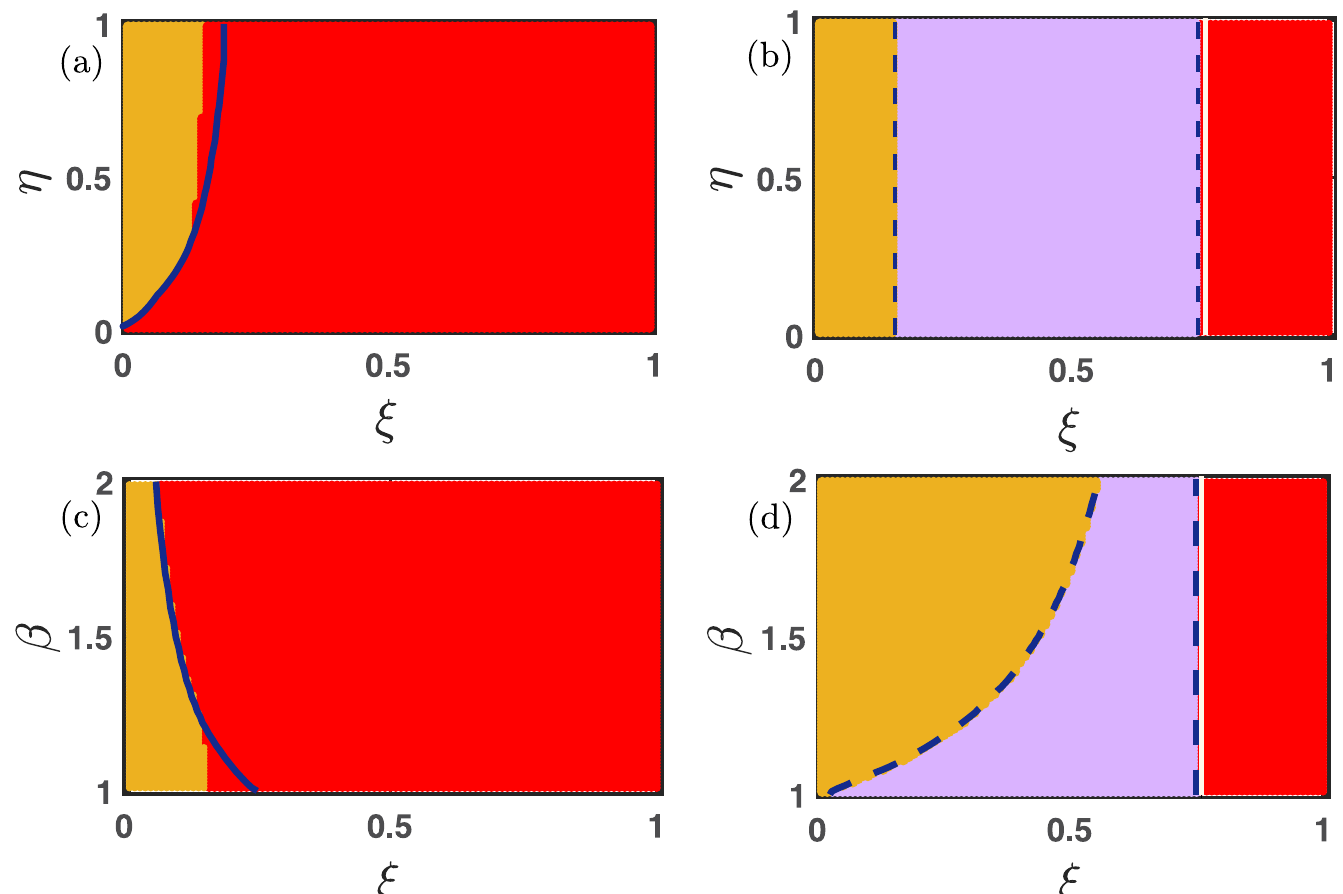
Fig 3. Influence of death rate ξ in the mutation-free model (8). The influence of game parameters β and η and the mortality rate ξ on the emergent dynamics of the model (8) in the absence of mutation is examined here. Subfigures (a) and (c) are drawn with σ 1 = σ 2 = 0. While subfigures (b) and (d) are generated with σ 1 = 0.75 and σ 2 = 0.25. Since, σ 1 > σ 2 , we notice a fair portion of defector-free region (violet points) in subfigures (b) and (d). In the absence of free space induced benefits, we are unable to trace such defector-free regions in subfigures (a) and (c). The red region reflects the disappearance of all individuals for relatively high values of death rate ξ . Note that we keep the value of p fixed at 0.3. Thus, the system gets more opportunities to play the SD game, which generally encourages stabilizing the coexistence equilibrium. Therefore, we notice lower values of ξ will lead to the convergence towards the coexistence equilibrium E 3 (yellow points). β is kept fixed at 1.1 for the subfigures (a-b) and η is set at 0.85 for subfigures (c-d). We iterate the system (8) with μ = 0 for 20 × 10 5 iterations with fixed integration step size δ t = 0.01 and fixed initial condition ( x 0 , y 0 ) = (0.35,